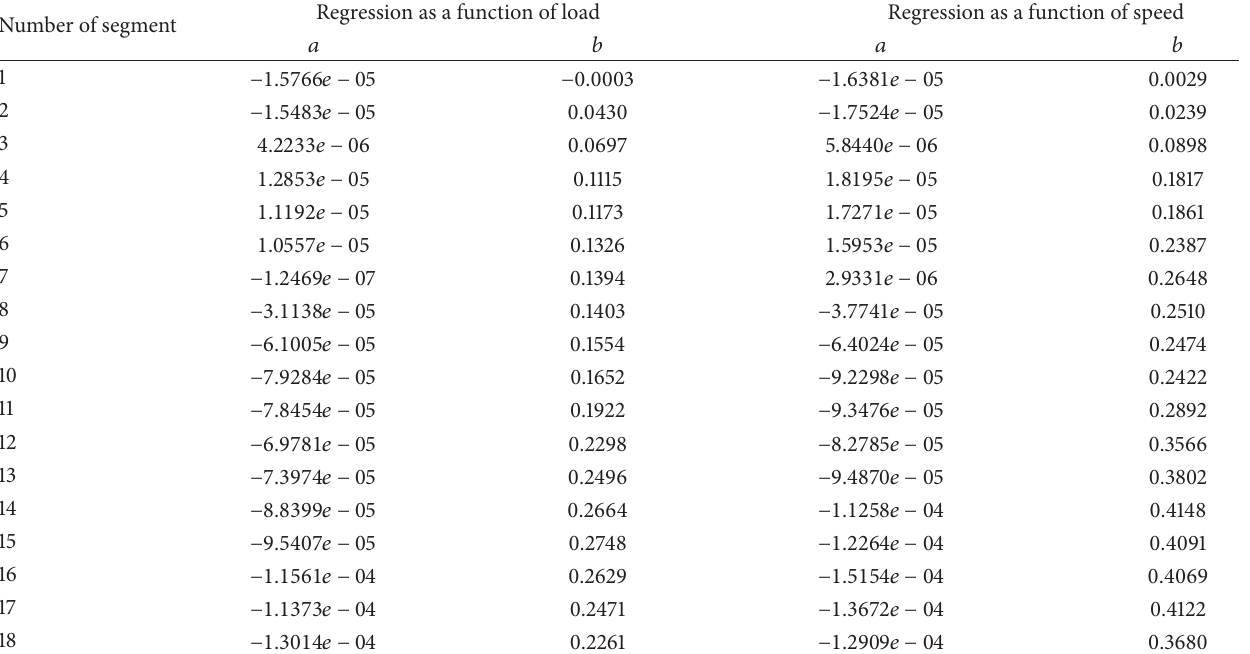
Table 1: Regression parameters a and b for PP feature.